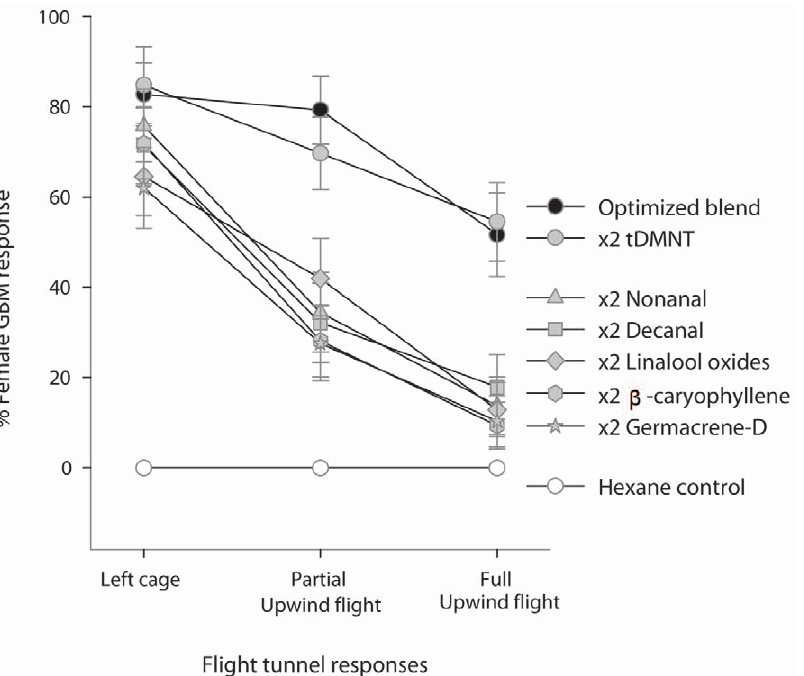
Figure 1. Response of female P.viteana to doubling the ratio of a single volatile constituent. Flight responses (% 6 1 SE ) of female P. viteana ( N =241) in the flight tunnel to hexane control, 7-component ‘‘optimized blend’’, and six ratio-modified synthetic blends. Ratio modification was done systematically by doubling one compound in the optimized blend singly and is indicated by ‘‘x2’’ in the figure legend. Partial upwind flight was recorded when P. viteana made more than 50 cm of zig-zag upwind flight toward the target. Full upwind flight was the upwind flight to within 10 cm of the target. An average of 30 individual moths was flown to each target tested. tDMNT: 4,8-dimethyl-1,3( E ),7-nonatriene.